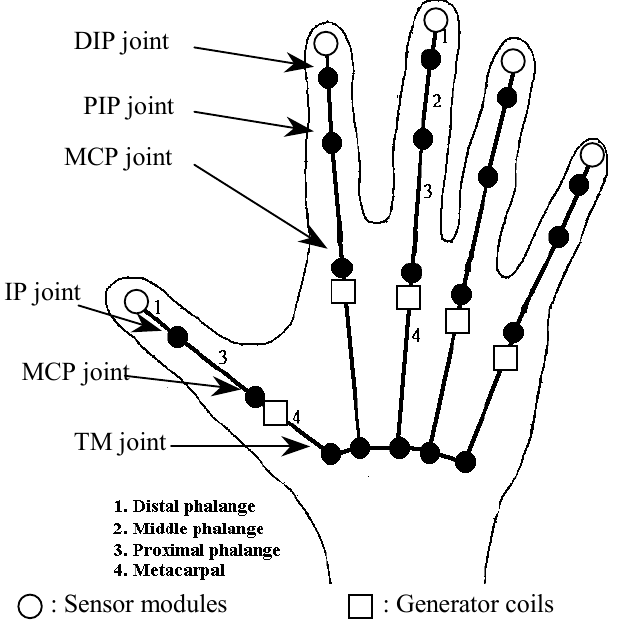
Figure 4. The hand model and the positions of the sensor modules and generator